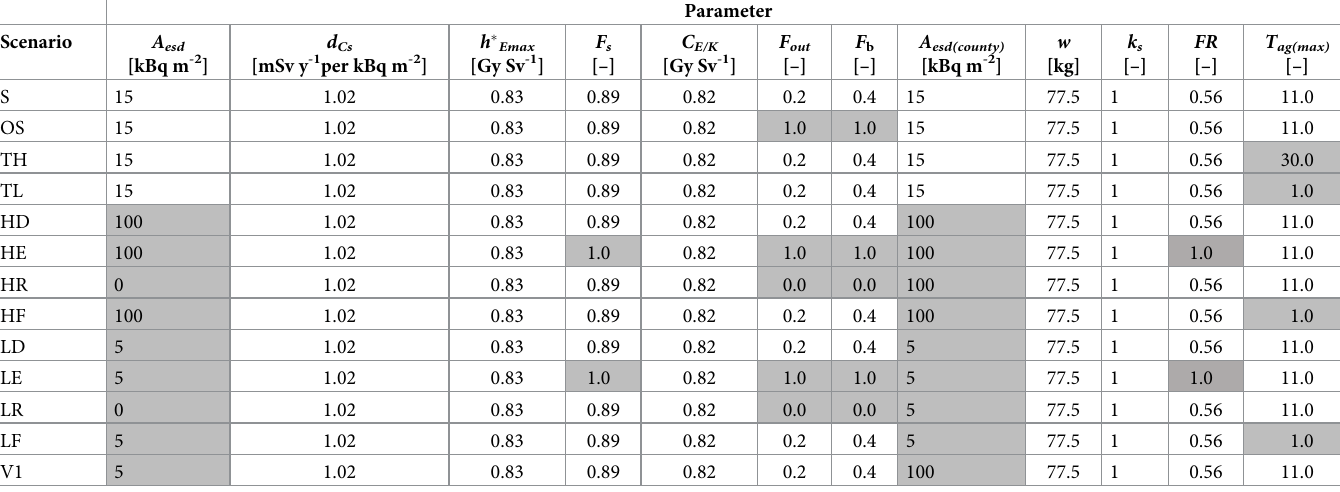
Table 3. Parameter values for adult males, used for calculations in the various scenarios listed in Table 2. (Shading indicates parameter values that are changed com- pared to the standard scenario (S)).